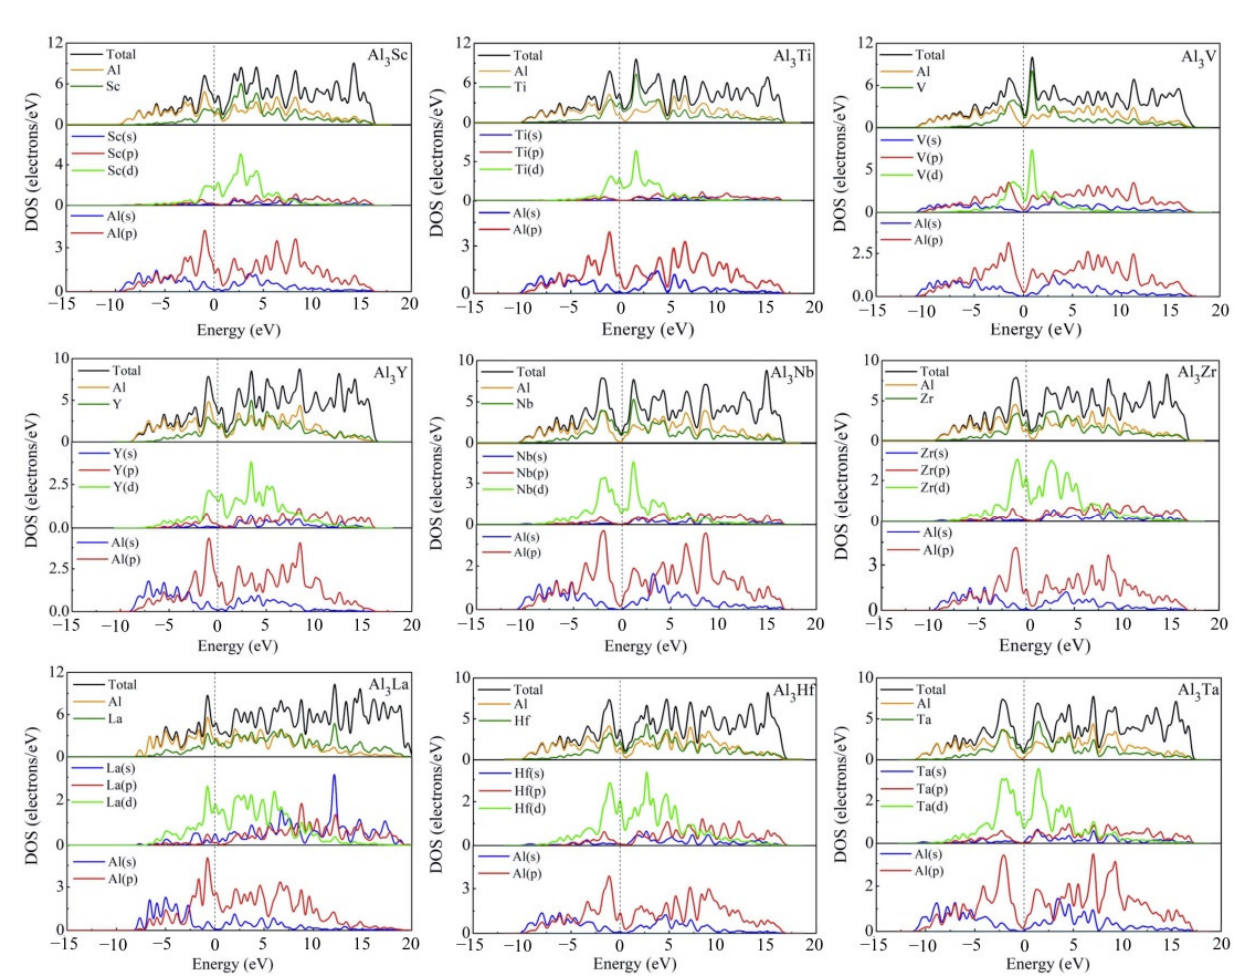
Figure 9. Total and partial electronic densities of states near Fermi level of Al 3 TM compounds. The PDOS curves clearly show that the contribution of Al-s on the surface of Fermi level is small, which is mainly contributed by the Al-p state. The Fermi level of TDOS is mainly formed by the strong hybridization of Al-p and TM (TM = Sc, Ti, V, Y, Zr, Nb, La, Hf, Ta)-d states. Obviously, the hybridization of Al-s and TM (TM = Sc, Ti, V, Y, Zr, Nb, La, Hf, Ta)-s states are less helpful for the Fermi level of TDOS. The obtained quantity of bonding electrons per atom between − 13 eV and Fermi level is 3.005, 3.243, 3.493, 3.003, 3.242, 3.499, 2.997, 3.247, and 3.501 for Al 3 Sc, Al 3 Ti, Al 3 Y, Al 3 V, Al 3 Zr, Al 3 Nb, Al 3 La, Al 3 Hf and Al 3 Ta, respectively. Meanwhile, in order to explore the chemical bonds and charge transfer in all D0 22 -type compounds, the charge density difference on the (010) basal plane of these compounds were considered. In Figure 10, the distribution state of charge density difference of Al 3 Sc, Al 3 Ti, Al 3 V, Al 3 Y, Al 3 Zr, Al 3 Nb, Al 3 La, Al 3 Hf, and Al 3 Ta can be seen clearly. The values of charge density difference map are plotted from − 0.04 to 0.04 e/Å 3 . Besides, the red and blue mean separately the aggregation and reduction of